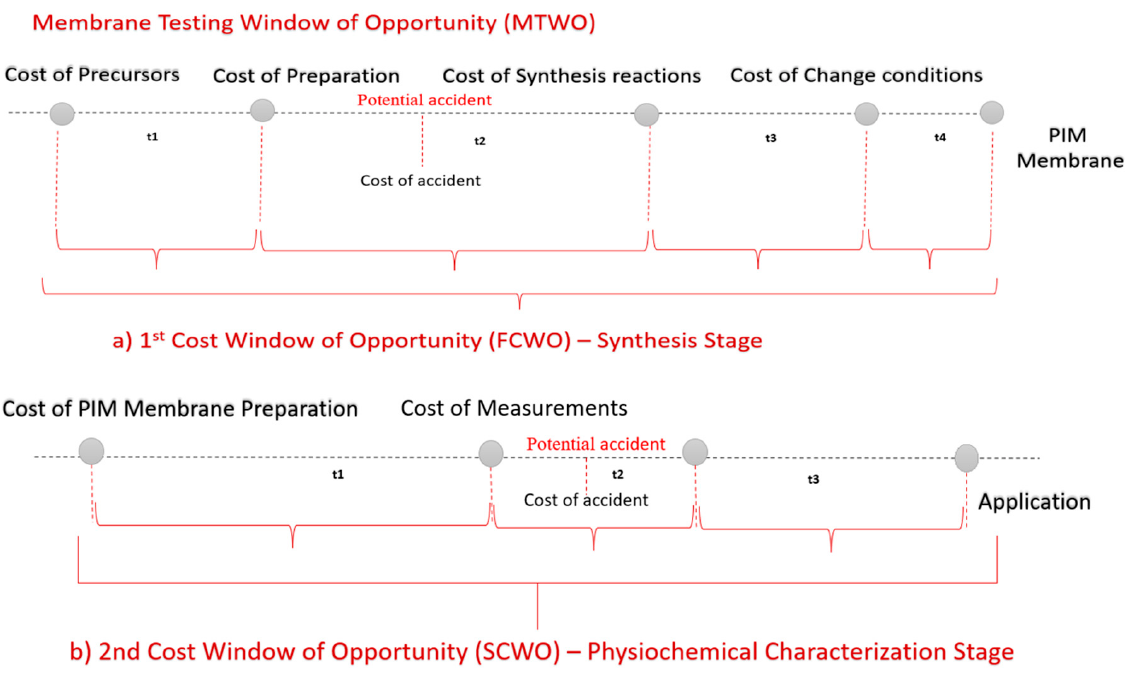
Figure 1. ( a , b ) Membrane testing cost window of opportunity in lab